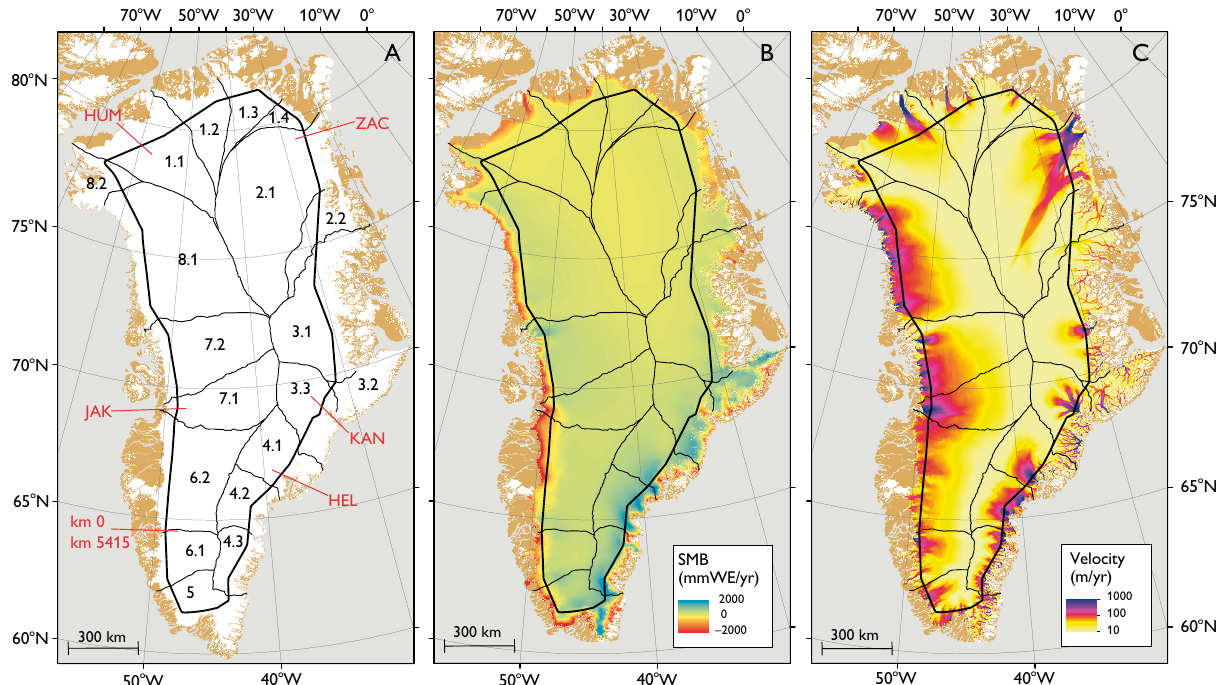
Fig. 1. A The PROMICE perimeter and nineteen ice sheet sub-sectors (Zwally et al . 2012). Major glaciers (Jakobshavn (JAK), Humboldt (HUM), Zacha- riae (ZAC), Kangerlussuaq (KAN) and Helheim (HEL)) are shown for reference. B Average surface mass balance (SMB) in mm of water equivalent (WE) per year over the 1980–1999 period from four MAR3.5.2 simulations (Fettweis et al . 2017). C Satellite-derived ice-surface velocity during winter 2008/2009 (Rignot & Mouginot 2012). Both surface mass balance and ice-surface velocity data are only shown within the PROMICE ice-sheet mask, excluding independent ice caps and glaciers (Citterio & Ahlstrøm